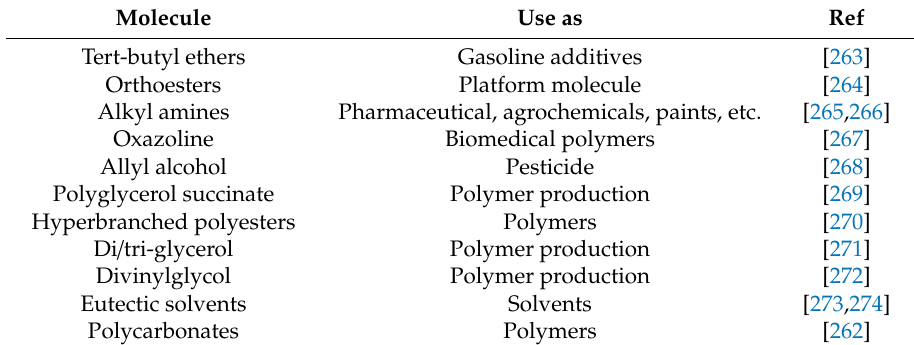
Table 7. Summary of some molecules produced from glycerol through heterogeneous